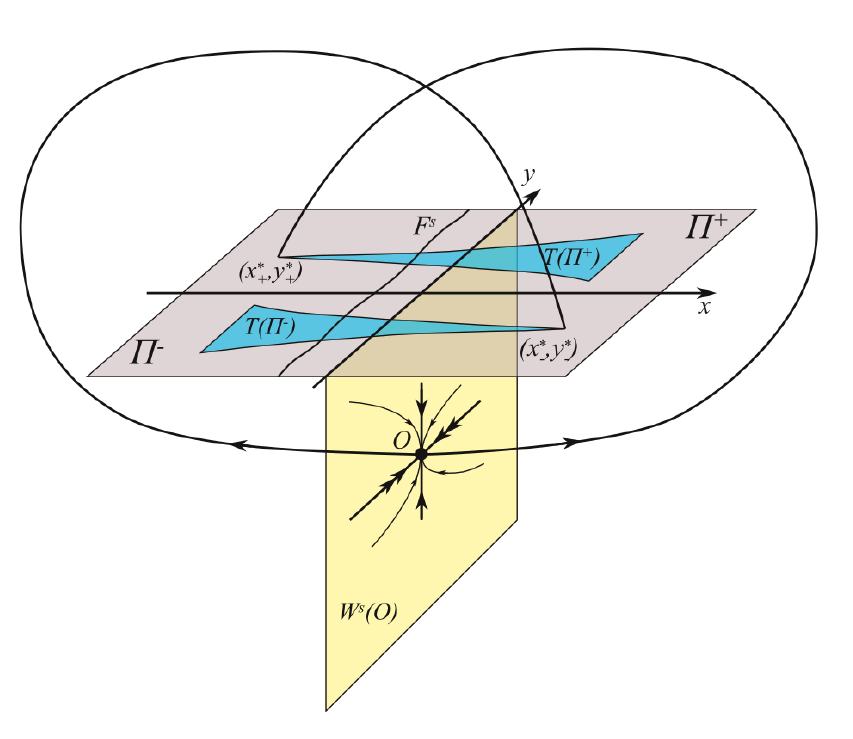
Fig. 1 Afraimovich-Bykov-Shilnikov geometric model of Lorenz